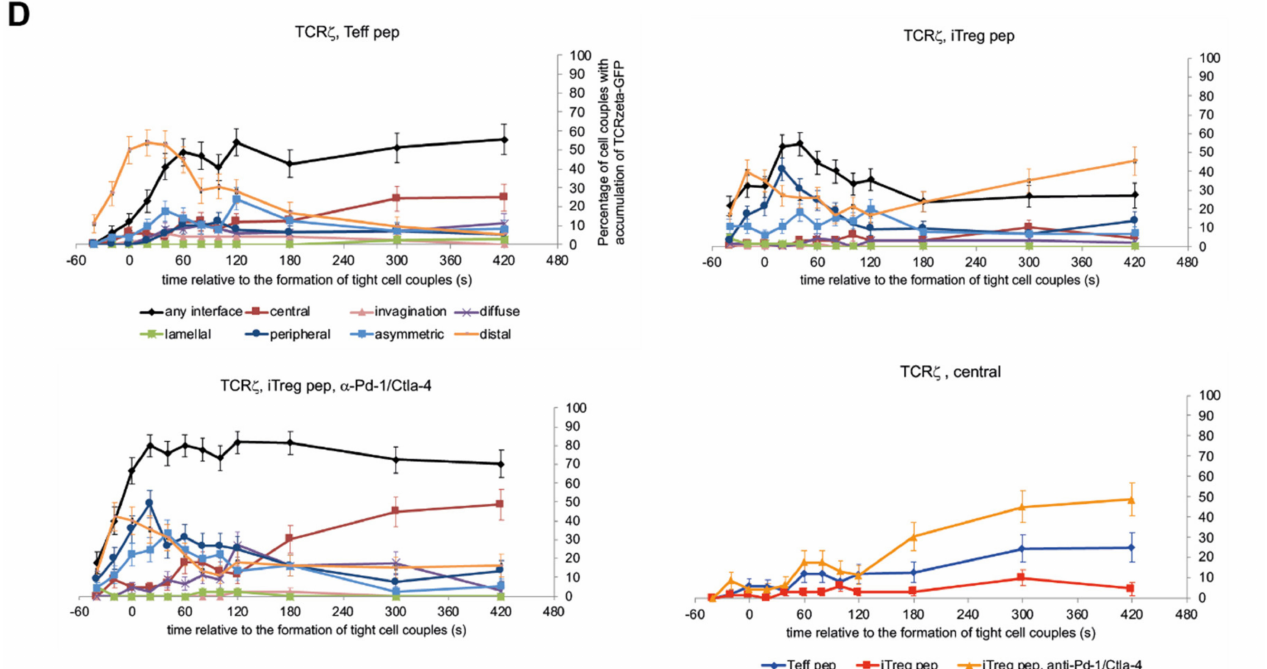
Figure 7. Pd-1 and Ctla-4 impair cSMAC formation upon induction of a regulatory phenotype. ( A – C ) Tg4 T cells as indicated transduced to express LAT-GFP were activated with PL8 APCs (10 µ g/mL Ac1-9[4Y]). A Representative LAT-GFP imaging data upon treatment with 10 µ g/mL α -Pd-1 plus α -Ctla-4 as in Figure 2A. A corresponding video is available as Video S9. ( B ) The data are expressed as the percentage of cell couples with LAT-GFP accumulation in the indicated patterns (Supplementary Figure S2A) relative to tight cell couple formation. Number of cell couples analyzed are n = 51 for iTreg pep cells in the presence of 10 µ g/mL α -Pd-1 plus α -Ctla-4 from 3 independent experiments. Statistical significance of differences between conditions is given in Table S10. Teff pep and iTreg pep data are from Figure 2B. The panel in the third row at the left is a direct comparison of central accumulation under the three experimental conditions. ( C ) The same data are expressed as the log 2 of the ratio of percent Tg4 T cells with accumulation in the central over the invagination pattern relative to tight cell couple formation. Teff pep and iTreg pep data are from Figure 2D. Data points are slightly nudged to increase legibility. ( D ) Tg4 T cells as indicated transduced to express TCR ζ -GFP were activated with PL8 APCs (10 µ g/mL Ac1-9[4Y]). The graphs display the percentage of cell couples with TCR ζ -GFP accumulation in the indicated patterns (Supplementary Figure S2A) relative to tight cell couple. Number of cell couples analyzed are n = 45 for iTreg pep cells in the presence of 10 µ g/mL α -Pd-1 plus α -Ctla-4 from 2 independent experiments. Statistical significance of differences between conditions is given in Table S10. Teff pep and iTreg pep data are from Figure 3B. The panel in the last row on the right is a direct comparison of central accumulation under the three experimental